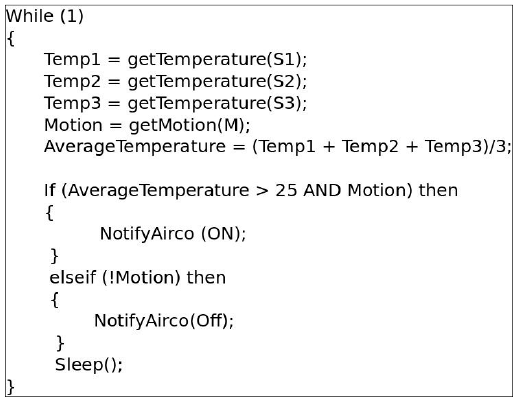
Figure 8. Sample Code Executed on Non-constrained Devices.